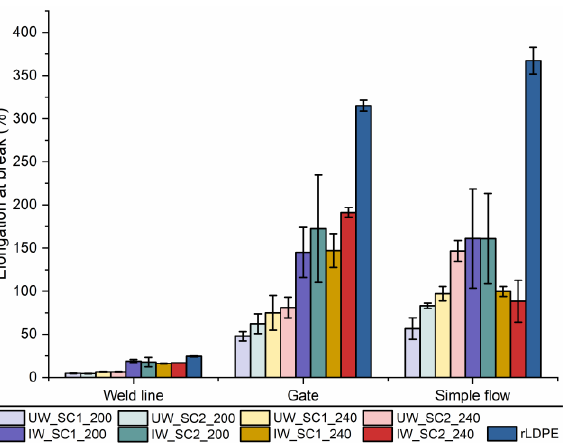
Figure 7. The elongation-at-break values of the samples, taken from different regions of the IM frame.